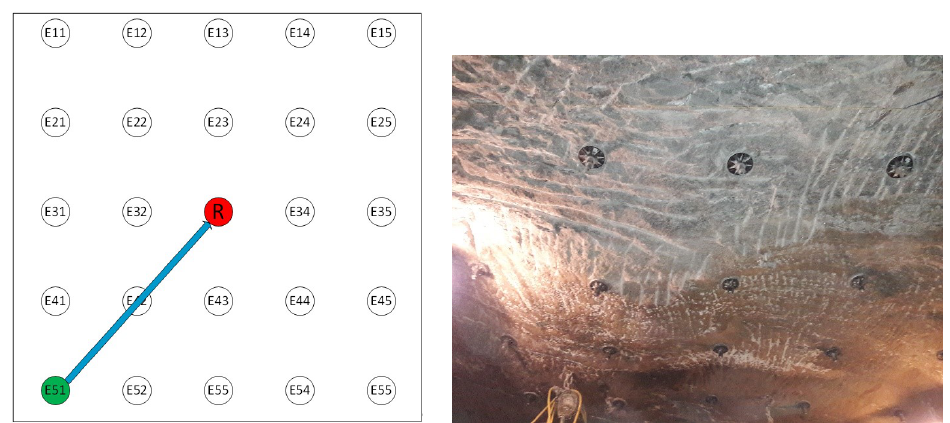
Figure 15. Diagram of anchor head arrangement and view of the actual bolted roof.